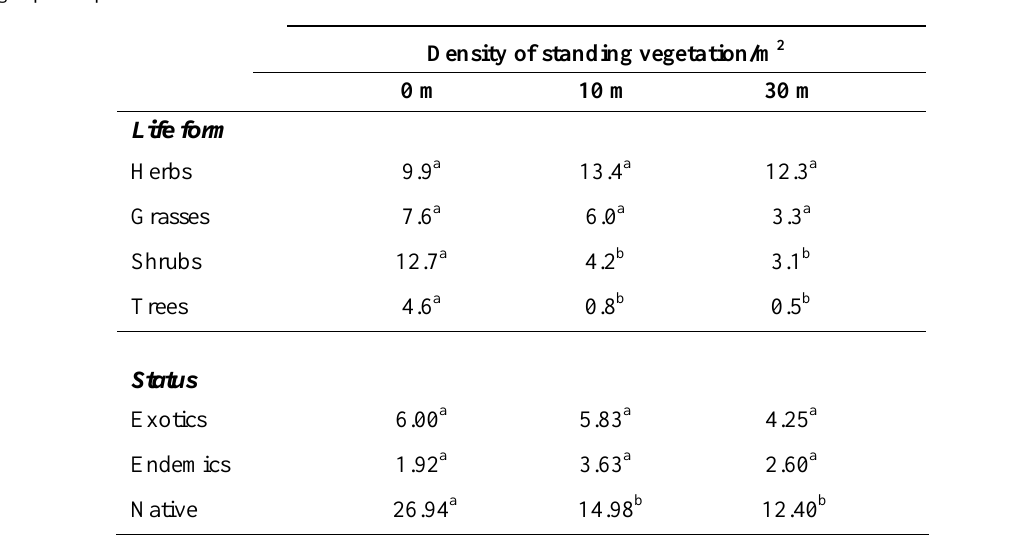
Figure 2: The cumulative number of germinable seeds of Austroeupatorium inulifolium and total number of seeds over the incubation period at different distances away from the forest-grassland ecotone (FEG, 10 m, and 30 m) in wet and dry season soil samples. Seedling emergence was monitored for nearly three months. Table 3: The density (per m 2 ) of the standing vegetation at 0 m, 10 m and 30 m distances away from the forest grassland edge (FGE); significant differences between distances are indicated for different life forms and ecological status separately using superscript